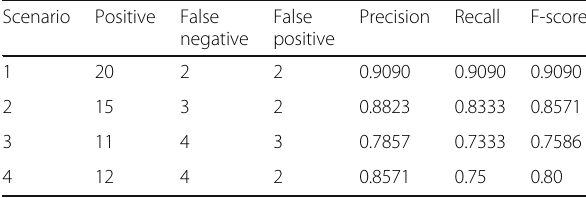
Table 3 Performance analysis of Secure-MQTT Scenario Positive False